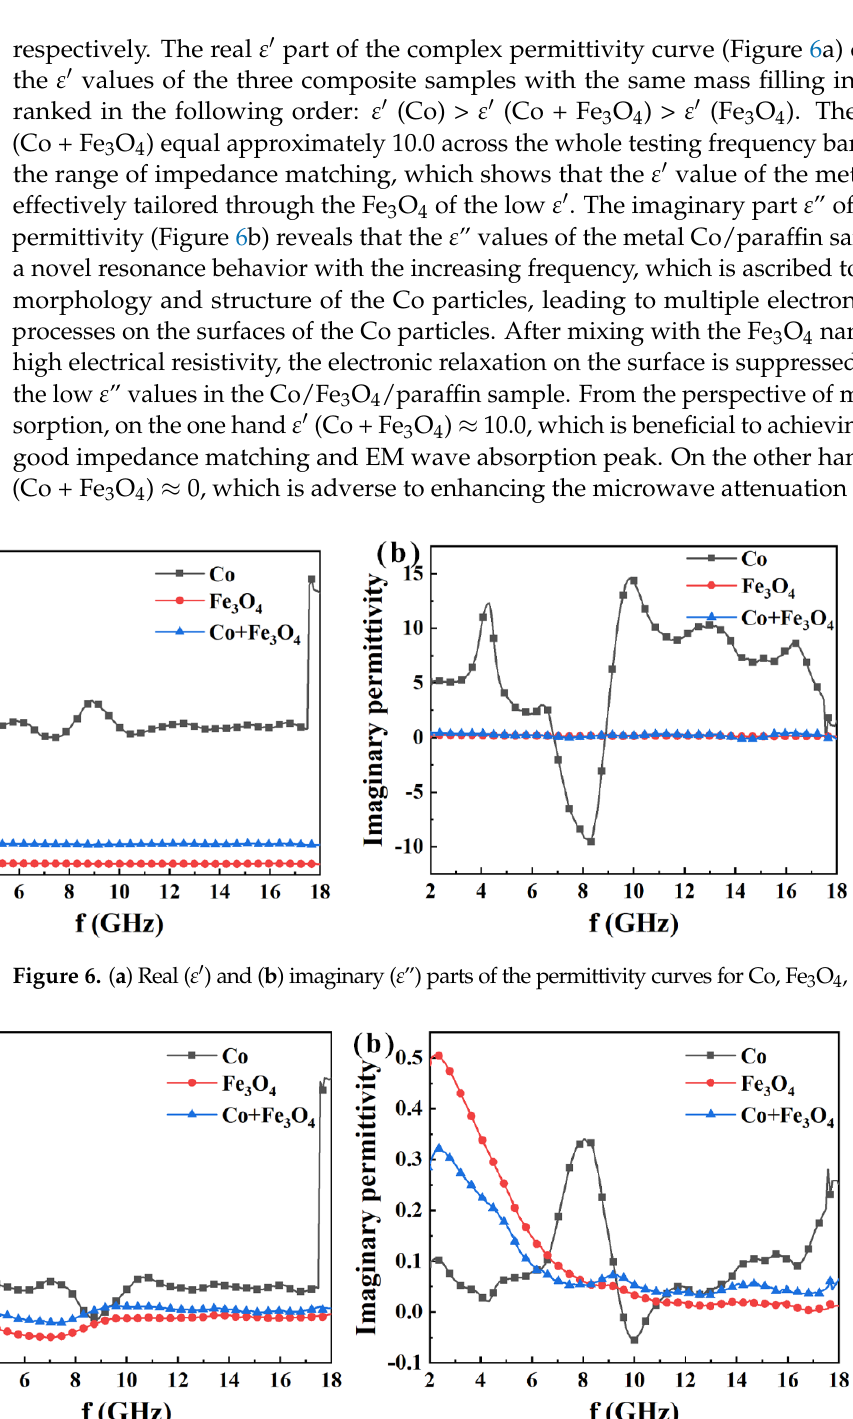
Figure 8. ( a ) Magnetic loss angle tangent (𝑡𝑎𝑛𝛿 (cid:3040) ) and ( b ) dielectric loss angle tangent (𝑡𝑎𝑛𝛿 (cid:3032) ) . The EM wave absorption performance at normal incidence over 2–18 GHz is evaluated by simulating the reflection loss ( 𝑅𝐿 )-frequency ( 𝑓 ) curves at different thicknesses using the transmission line formulas, based on the measured EM parameters, as shown in Figure 9. It can be observed that the |𝑅𝐿| values of the Fe 3 O 4 /paraffin sample are very low due to the weak dielectric loss ability of the Fe 3 O 4 nanoparticles (Figure 8b). The |𝑅𝐿| values of the Co clusters with paraffin are relatively high. All of the 𝑅𝐿 peaks exceed − 10 Db and the minimum 𝑅𝐿 value ( 𝑅𝐿 (cid:3040)(cid:3036)(cid:3041) ) is up to − 25.73 Db at 4.485 GHz when the absorber thickness is 2.2 mm, showing that the Co clusters are suitable for EM absorption in low-frequency bands, which can only be attributed to relatively good impedance matching, since the magnetic loss and dielectric loss are not the highest (Figure 8). If the EM parameters of the Co clusters can be effectively tailored by the Fe 3 O 4 nanoparticles, a better and more tunable EM wave absorption performance can be